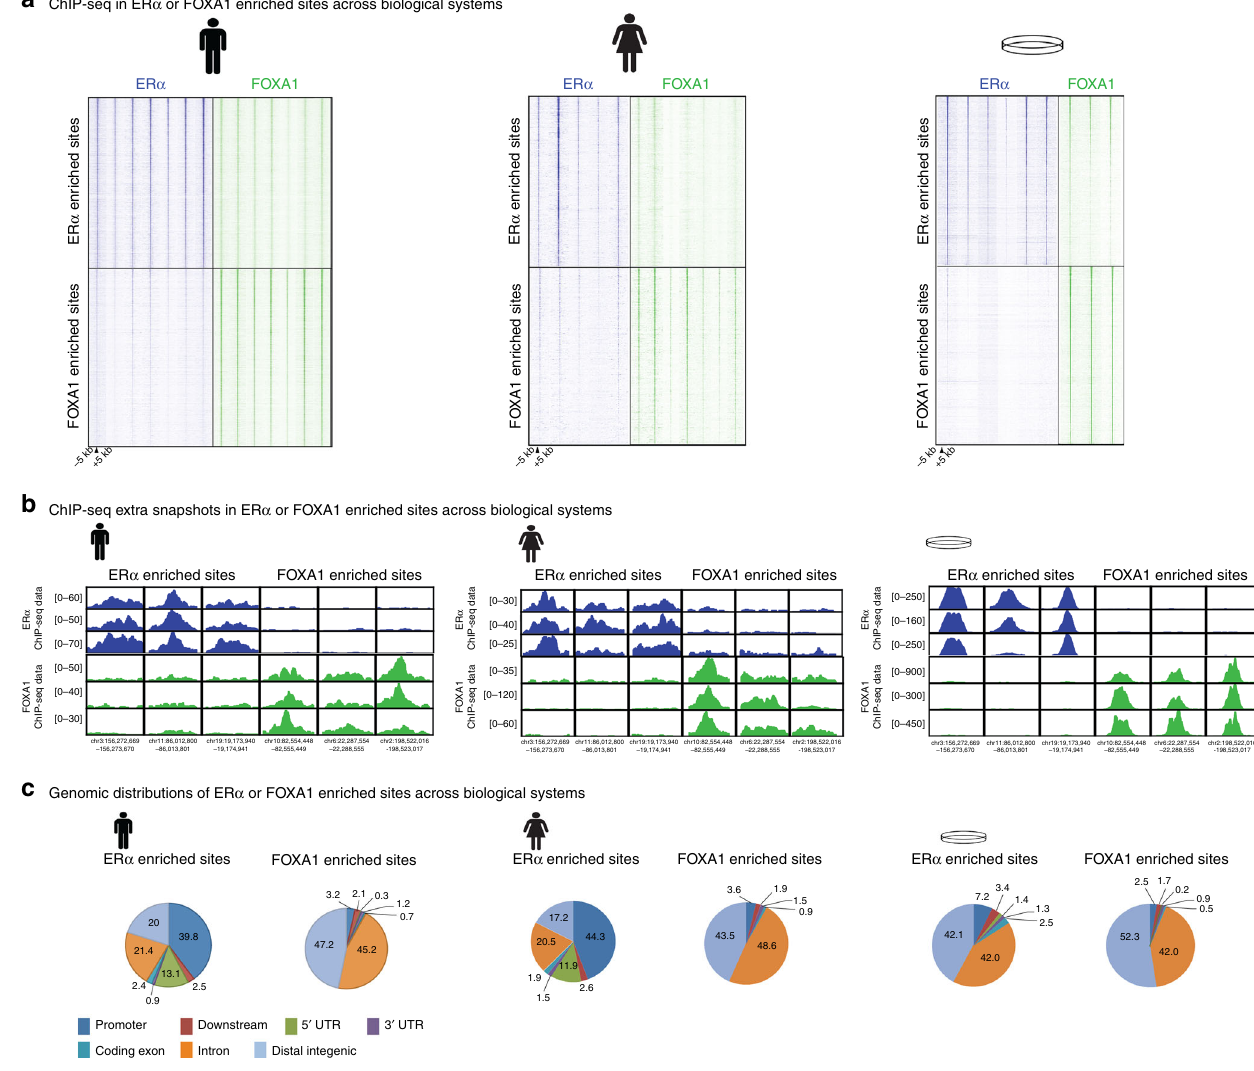
Fig. 3 ER α - and FOXA1-enriched binding sites across biological systems. a Heatmaps indicating the binding peak intensity in sites, differentially enriched between ER α (blue) and FOXA1 (green). Left, middle and right columns indicate male tumor, female tumor and female cell line data, respectively. The male silhouette was from Wikipedia (https://en.wikipedia.org/wiki/File:Male_Bathroom_Symbol.png). The female silhouette was from Wikipedia (https:// commons.wikimedia.org/wiki/File:Toilet_women.svg), from a collection commissioned by the United States Department of Transportation, designed by AIGA http://www.aiga.org/content.cfm/symbolsigns, and converted into SVG by Wikipedia-user Lateiner. The image is used under a CC-BY 2.5 license. b Genome browser snapshot depicting sites differentially bound by ER α or FOXA1 across biological systems. Genomic coordinates and read count are indicated. c Pie charts indicating genomic distribution of ER α - (left) and FOXA1-enriched (right) sites across biological small ( n = 3) sample size. Based on lymph node status, indicative performance distribution; Methods section; Supplementary Fig. 18). Dividing patients into two groups of equal size based on the signature (high-risk and row-risk group of LN-status) sig- ni fi cantly classi fi ed patients on distant metastasis free survival (DMFS; p = 0.048, log-rank test; Fig. 6f; Methods section), which was marginally signi fi cant in a multivariate Cox analysis includ- ing LN-status ( p = 0.066, Cox proportional hazards test). The gene expression signature is a linear combination of gene expression levels, in which 14 contributing genes classify MBC on outcome (Fig. 6g). Cumulatively, we show that global ER α and FOXA1 chromatin binding selectivity reveals gender-speci fi c prognostic features that successfully classify MBC patients on survival.